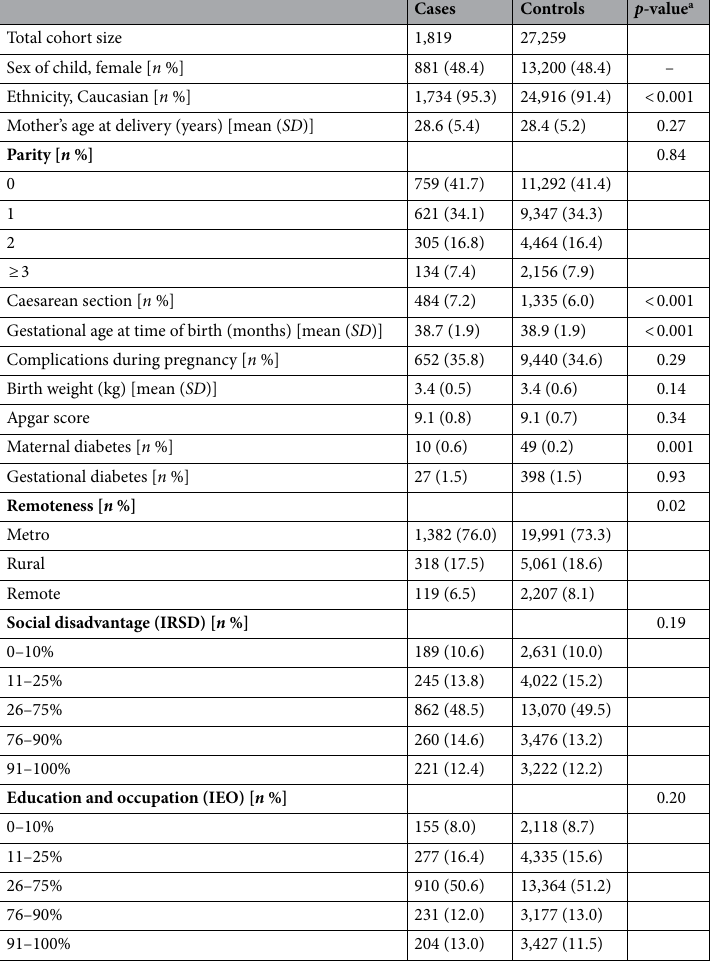
Table 1. Characteristics of children born in Western Australia between 1980–2014 diagnosed with type 1 diabetes (cases) and population controls. p -values from independent t -tests and chi-squared tests comparing cases and